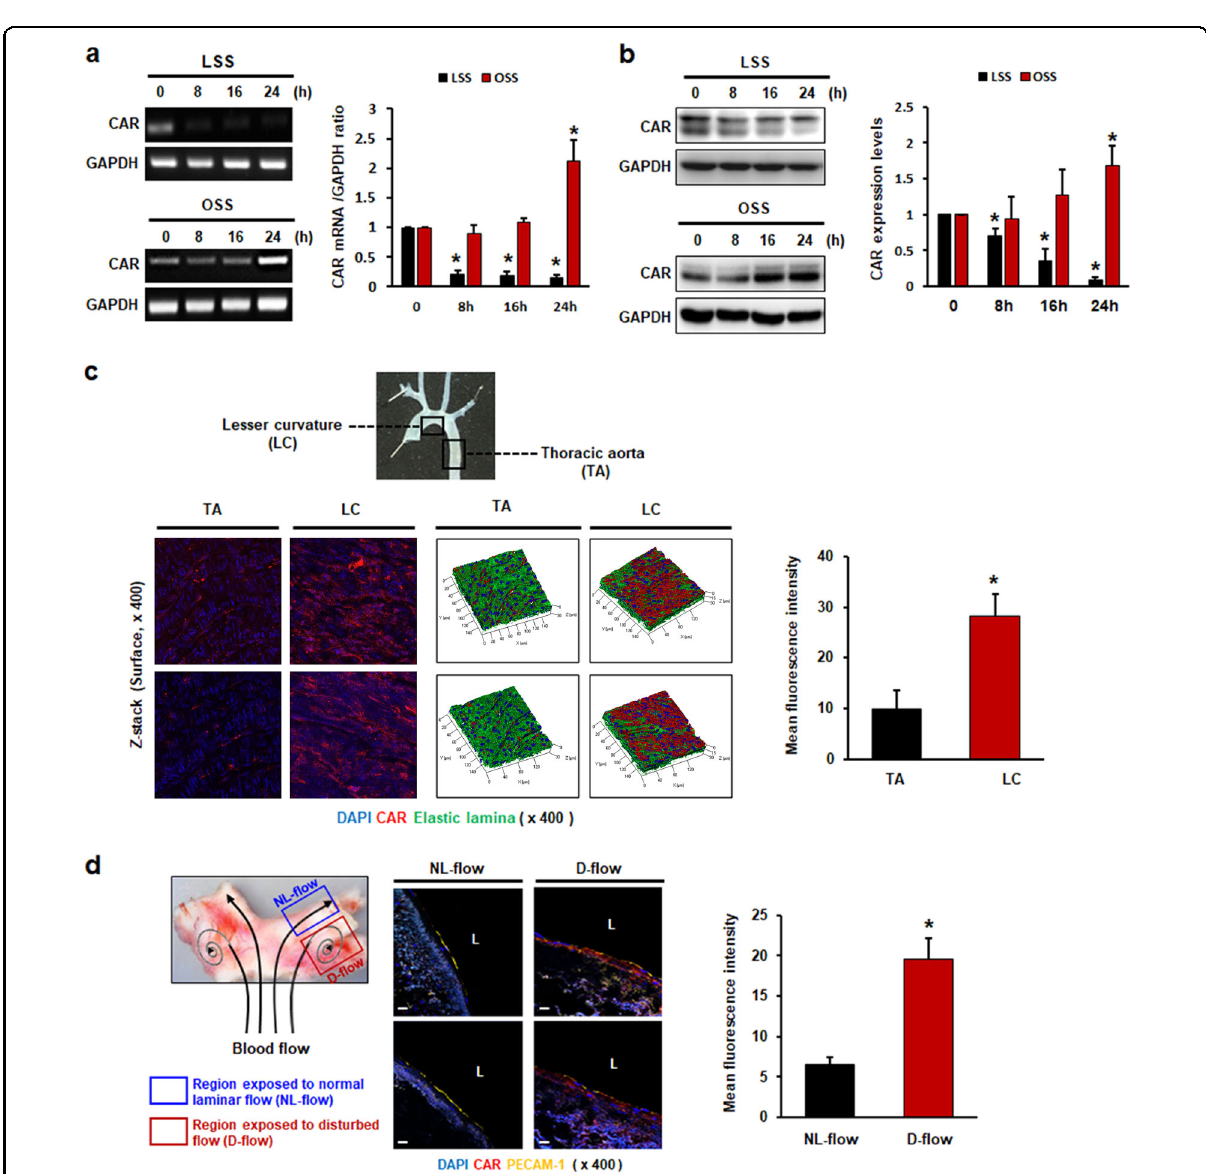
Fig. 1 Fluid shear stress regulates CAR expression in endothelial cells. HUVECs were cultured under static, LSS, or OSS conditions for the indicated periods of time. a Levels of mRNAs encoding CAR and GAPDH (internal control) were determined by RT-PCR. b CAR protein levels were measured by western blotting. Representative images are shown ( n = 5; compared with static conditions, * P < 0.05). c Mouse aortas were divided into two regions according to the distribution of vessel wall shear stress: the lesser curvature (LC; disturbed fl ow) and thoracic aorta (TA; normal laminar fl ow) 20 . The expression of CAR was evaluated by en face staining and confocal microscopy. Localization of CAR on the surface of the endothelium was veri fi ed by z-stack imaging (red, CAR; blue, nuclei; green, elastic lamina of vessel). d Frozen sections of human artery tissues 20 were stained with anti-PECAM-1 and anti-CAR antibodies. PECAM-1 was used as an endothelial-speci fi c marker. The expression of CAR was compared in two regions of the bifurcation site of the vessel with different wall shear stresses, the outer side with disturbed fl ow (D-Flow) and the inner side with normal laminar fl ow (NL-Flow), by confocal microscopy. Representative images from at least three experiments are shown (red, CAR; yellow, PECAM- 1; blue, nuclei). Scale bars, 10 μ